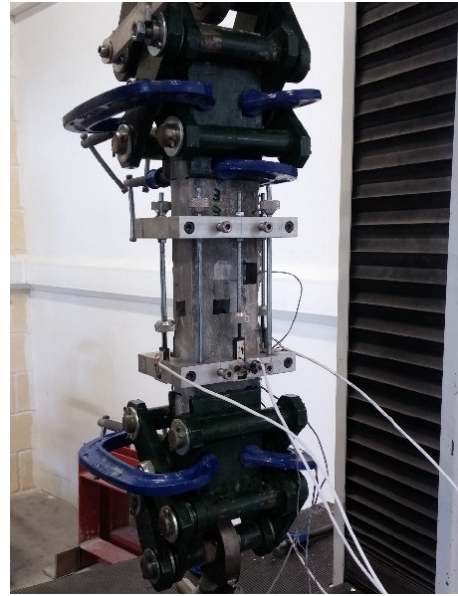
Figure 3. Set-up of direct tension test.